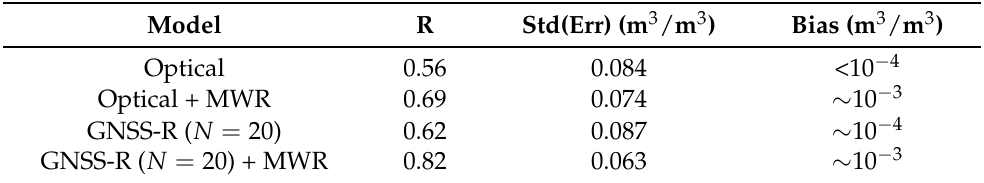
Table 2. Main performance parameters of the ANN based models implemented to infer SM from optical, MWR, and GNSS-R data.